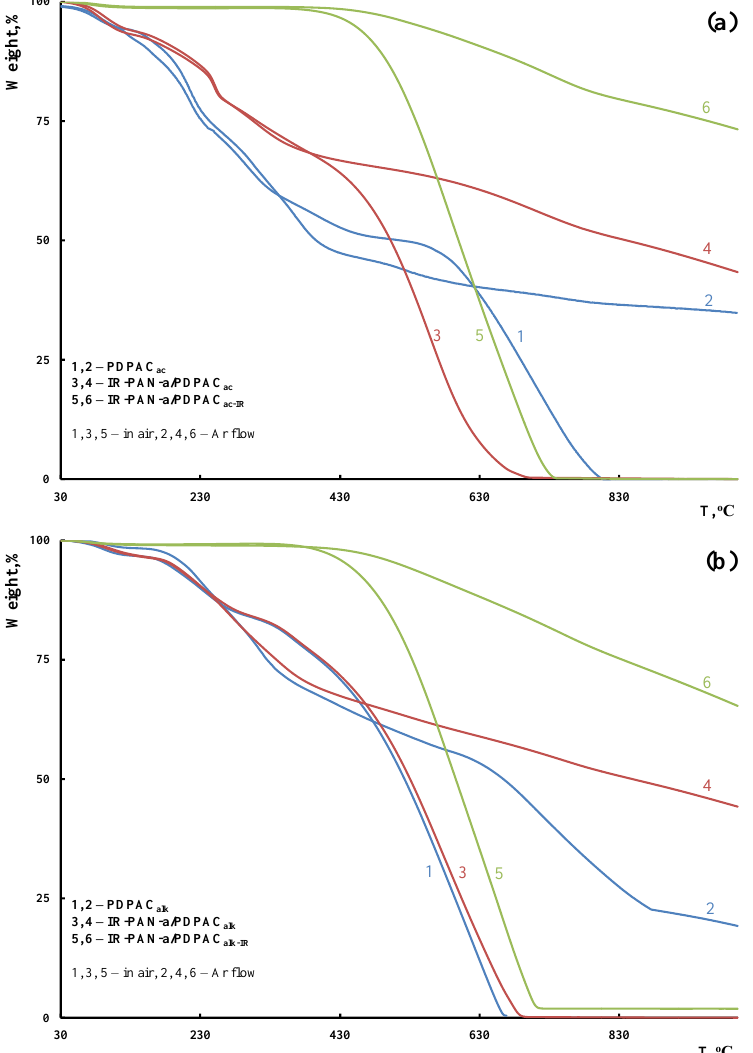
Figure 12. TGA thermograms of PDPAC (1, 2), IR-PAN-a/PDPAC (3, 4), and IR-PAN-a/PDPAC IR (5, 6) prepared in an acidic ( a ) and an alkaline medium ( b ) at heating of up to 1000 ◦ C in the Ar flow (1, 3, 5) and in the air (2, 4,